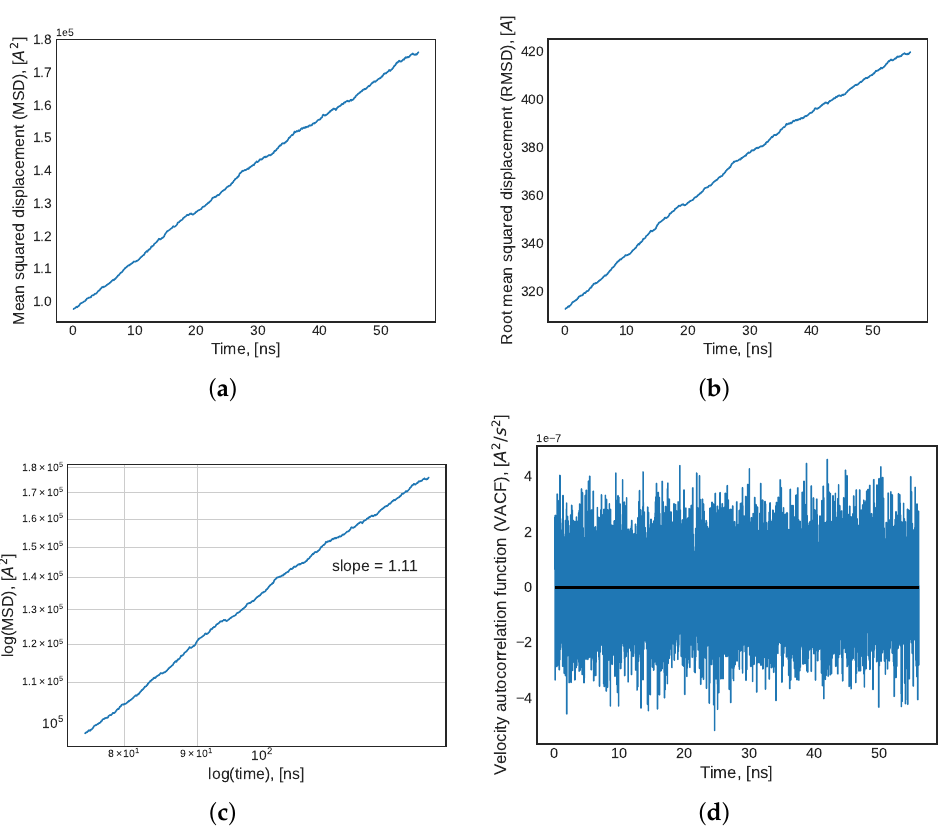
Figure 3. A pure water system at 25 ◦ C and atmospheric pressure: ( a ) mean squared displacement (MSD); ( b ) root mean squared displacement (RMSD); ( c ) log-log plot of MSD; and ( d ) velocity time autocorrelation function (VACF) during the last 50 ns segment of a 100 ns NVT